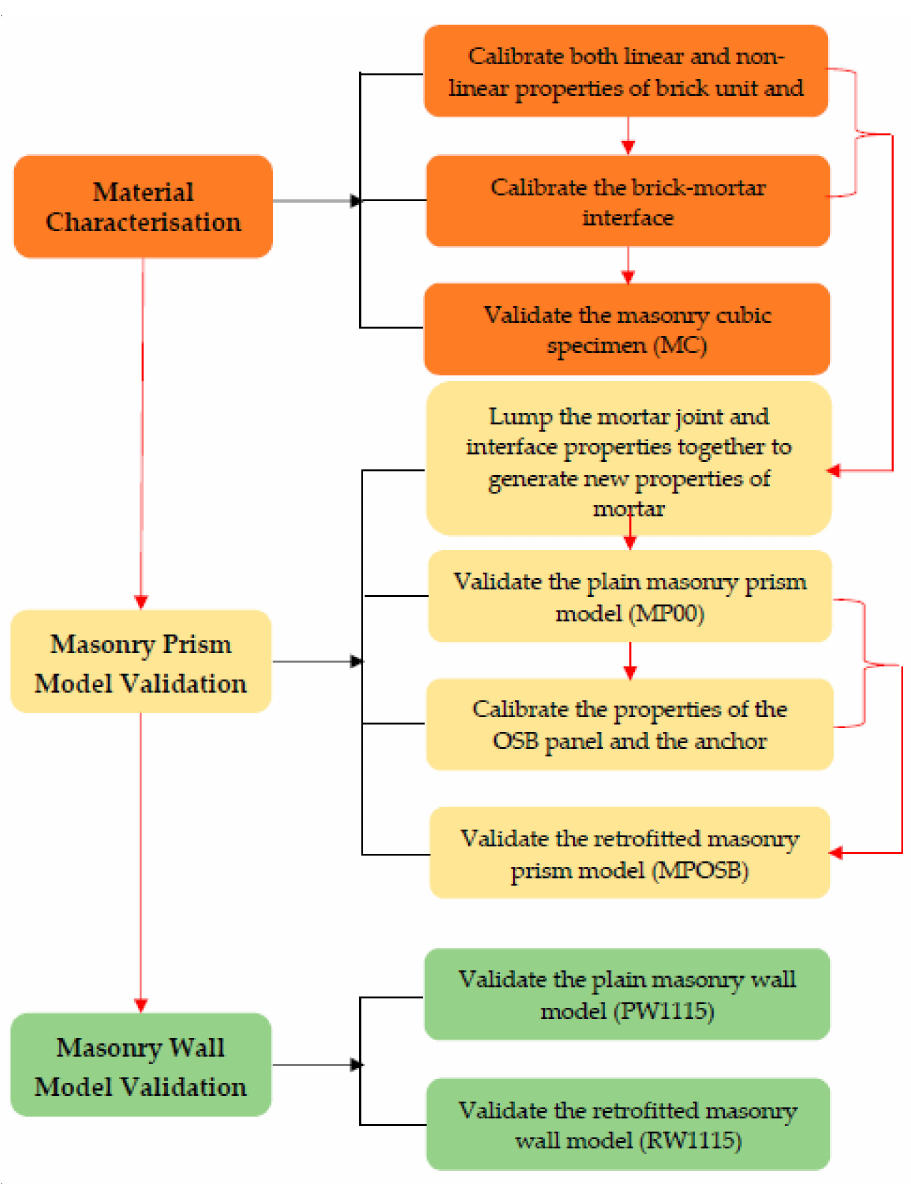
Figure 2. Full numerical analysis